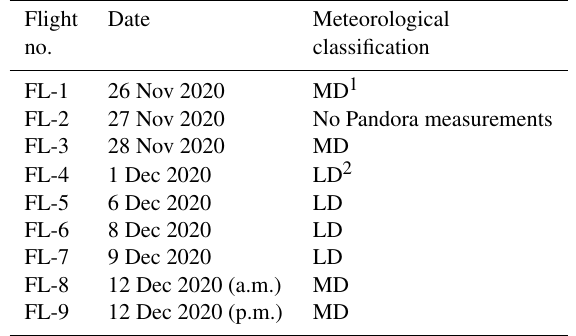
Table 2. Summary of aircraft measurements collected during the Geostationary Environment Monitoring Spectrometer